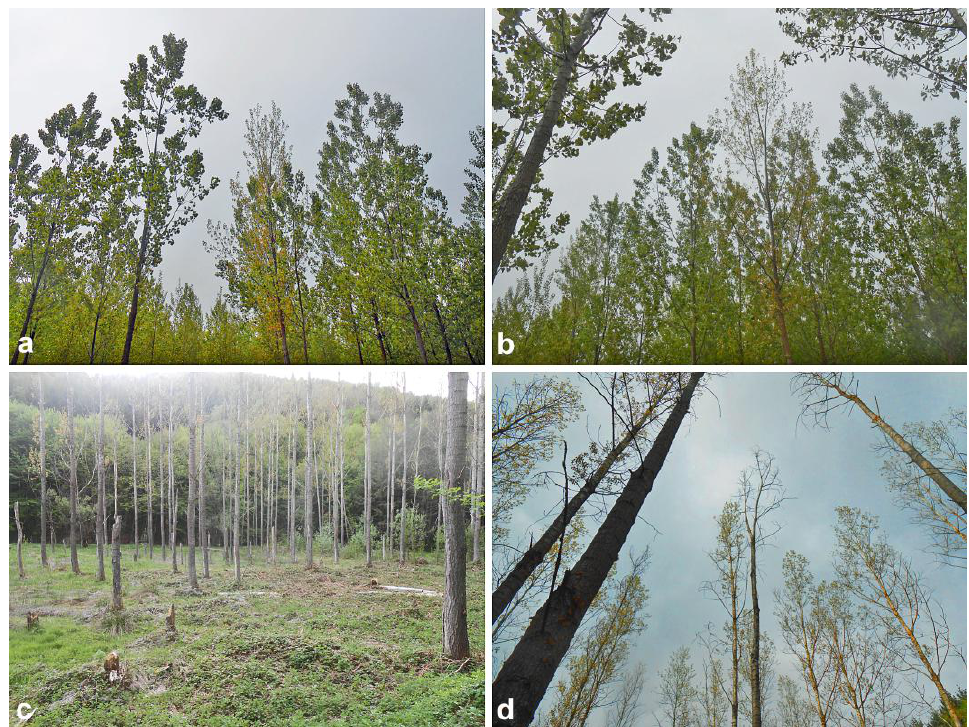
Figure 1. Disease symptoms in poplar plantations in Serbia: ( a , b ) increased crown transparency and yellowing of leaves on five-year old trees of Populus deltoides in stand No. 4; ( c , d ) severe mortality and dieback of 25-years old trees of Populus × euramericana clone I-214 in stand No. 5. 2.2. Sampling, Isolation, and Morphological Identification of Phytophthora